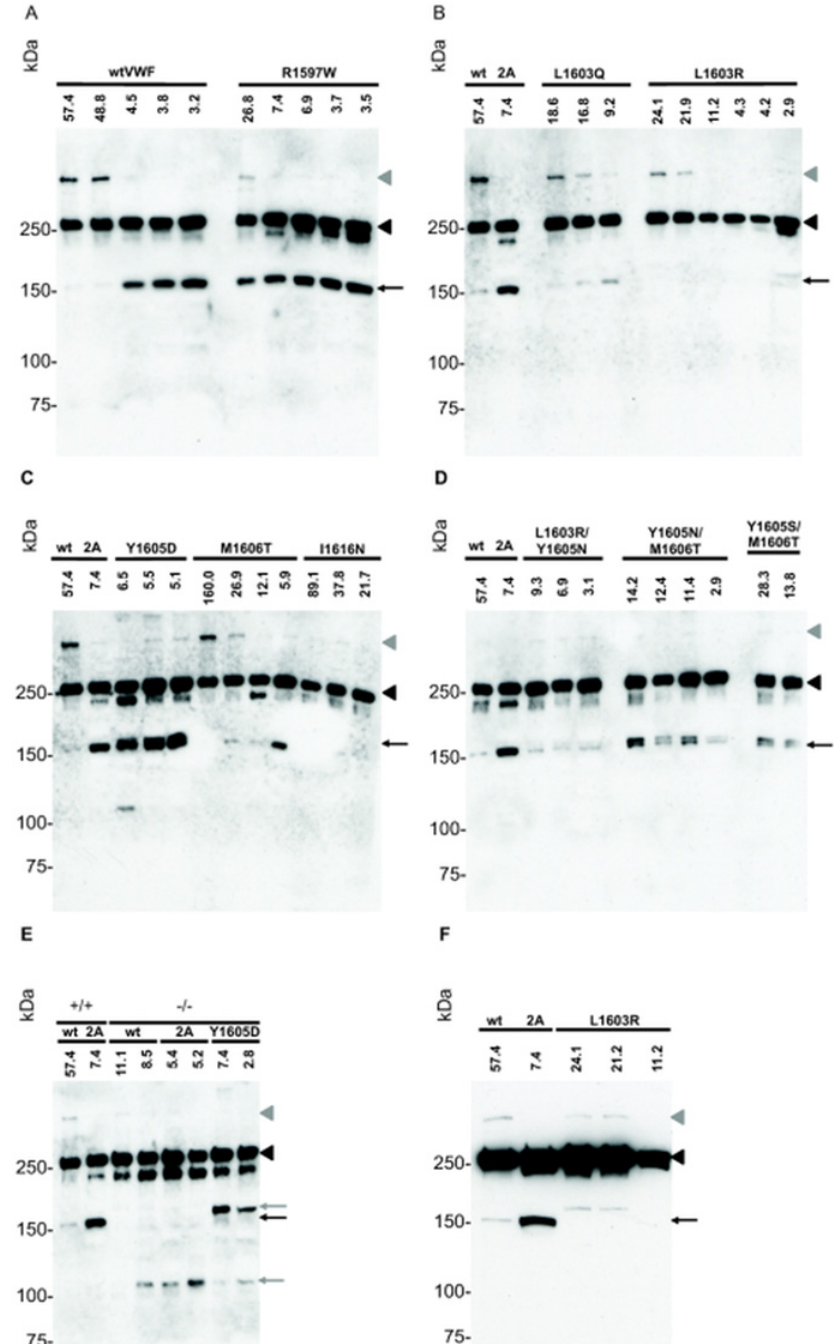
Fig 6. In vivo proteolysis of VWF mutants. FLAG tagged, plasma VWF, A-E ; 10ng load, F; 25ng load, were examined for proteolysis in 129X1/Sv Adamts13 +/+ or Adamts13 -/- mice by reducing SDS-PAGE and western blotting. Each lane represents an individual mouse with the VWF mutation(s) and VWF concentration in PPP as measured by ELISA (ug/mL). 10 ng of VWF was loaded per lane. Several forms of VWF were observed: proVWF (i.e., propeptide bound; gray arrowhead), uncleaved mature VWF (black arrowhead), Adamts13-mediated proteolysis (black arrow), and Adamts13-independent proteolysis (gray arrow). In the 2 left most lanes of B - F , wtVWF and R1597W are the same as the 1 st wtVWF and 2 nd R1597W of A , respectively.